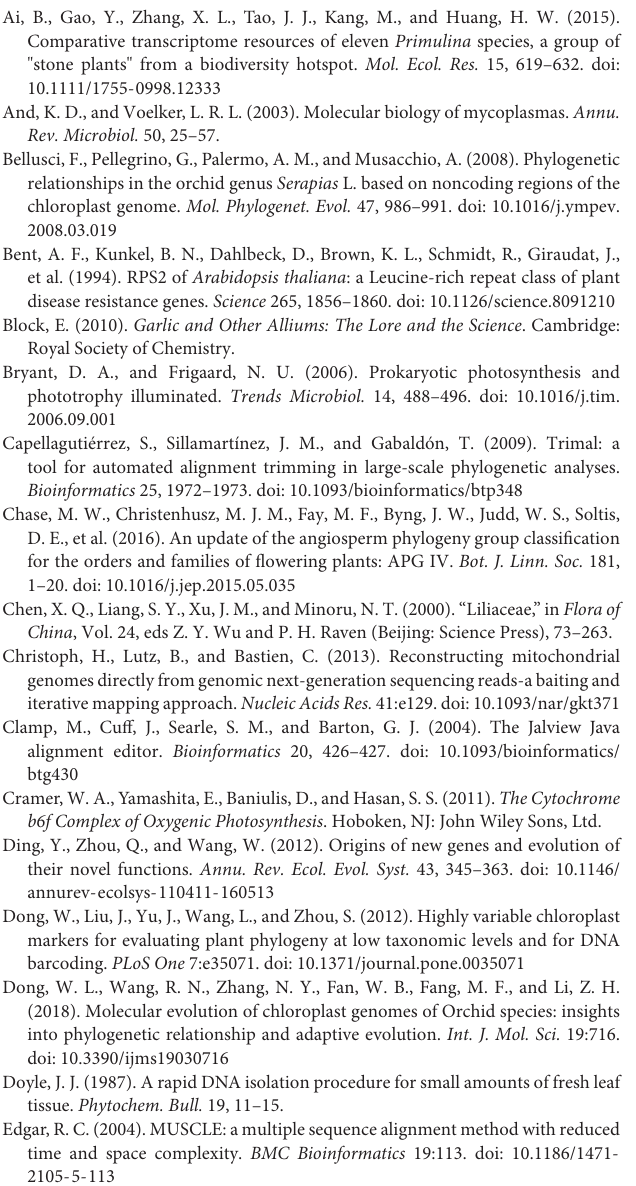
TABLE S4 | Gene content in Section Daghestanica species cp genomes. ∗ Genes with two copies. TABLE S5 | Summary of complete chloroplast genomes of all 41 taxa used in this study. TABLE S6 | The statistics of codon usage bisa in all 41 taxa used in this study. TABLE S7 | Summary of Pairwise Ka/Ks ratios in Allium (Allioideae) and other families. TABLE S8 | Statistics of simple sequence repeats in each species of Section Daghestanica . TABLE S9 | List of single-copy genes extracted from cp